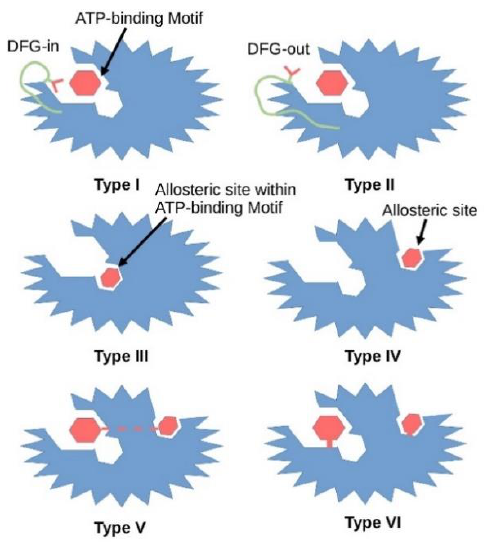
Figure 2. Graphical illustration of different types of kinase inhibitors and their mode of action. Dark red hexagon represents an inhibitor. The protein kinase is shown in blue, the DFG motif in green, the aspartate amino acid residue of the DFG motif in red. In 2015 Wu demonstrated that co-crystal structure of 3-phosphoinositide-dependent protein kinase 1 (PDPK1, PDK1) with ATP showed that type I inhibitors interact with the active conformation of the enzyme where the aspartate residue of the DFG motif points into the ATP binding pocket, while type II inhibitors stabilize the inactive conformation of the enzyme where the aspartate residue faces outward of the binding site (PDB entry: 4RRV). Type III inhibitors interact with the allosteric site within the ATP binding pocket. Type IV inhibitors interact with the allosteric site. However, the allosteric pocket is only a visualization and its place can be anywhere outside the ATP binding site. Type V inhibitors interact with both the allosteric and ATP binding pockets. Type VI inhibitors form covalent bonds with either the ATP binding pocket or the allosteric pocket.